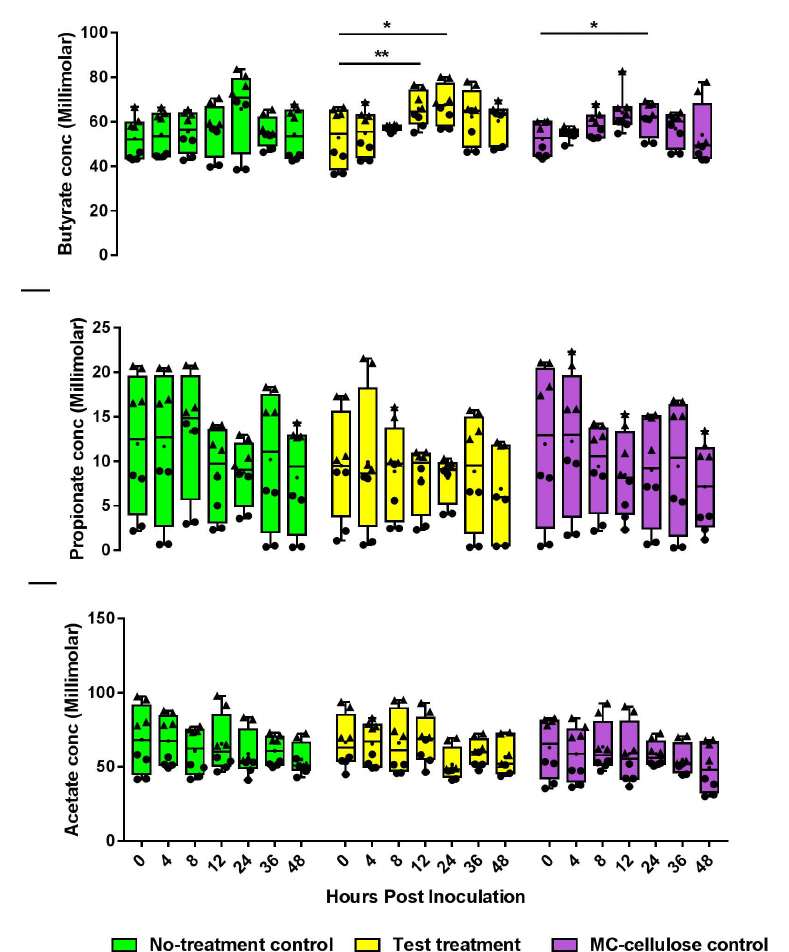
Figure 5. Short-chain fatty acids (SCFAs) concentration measured by GC over 48 h with a no-treatment control, microcrystalline cellulose control, and test treatment: butyrate, propionate and acetate from top to bottom. Each time point is represented with 4 biological replicates × 2 technical measures (triangles are for donor 1 samples and circles for donor 2 samples). Statistical comparisons were conducted among di ff erent treatments at the same time and among di ff erent time points within each treatment using repeated measures ANOVA test with Bonferroni as a post hoc test for multiple